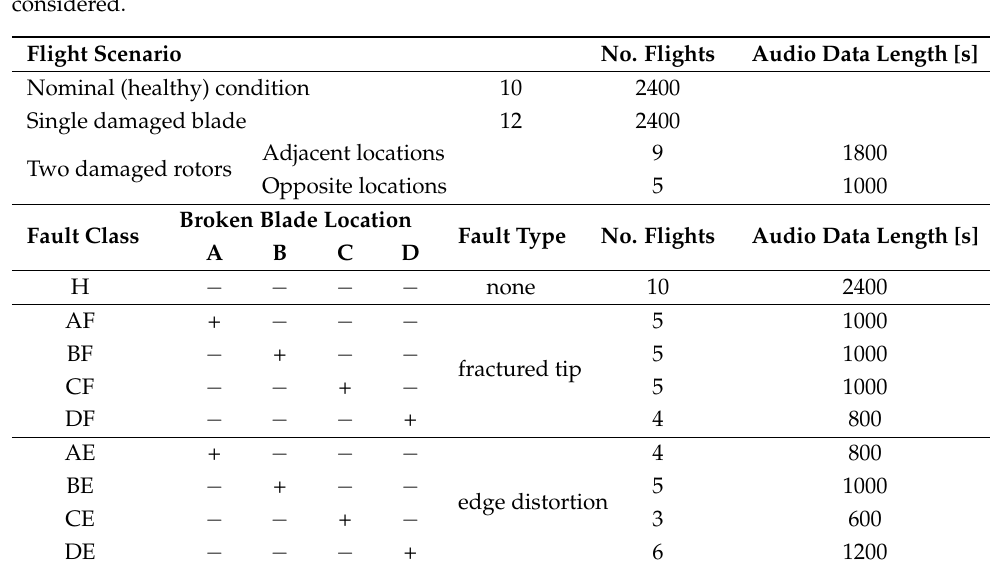
Figure 7. Structure of the LSTM-based fault classifier. Table 2. Summary of flight experiments conducted and the quantities of data for every fault class